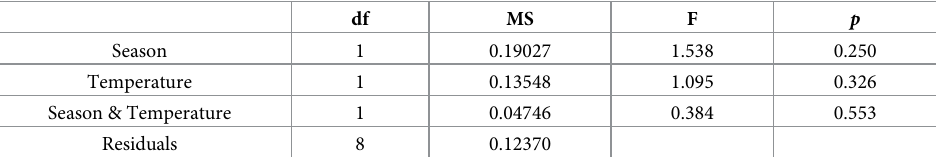
Table 4. Results of the 2–way ANOVA analysis of the factors temperature and season in the dissolved organic car- bon (DOC) fluxes.